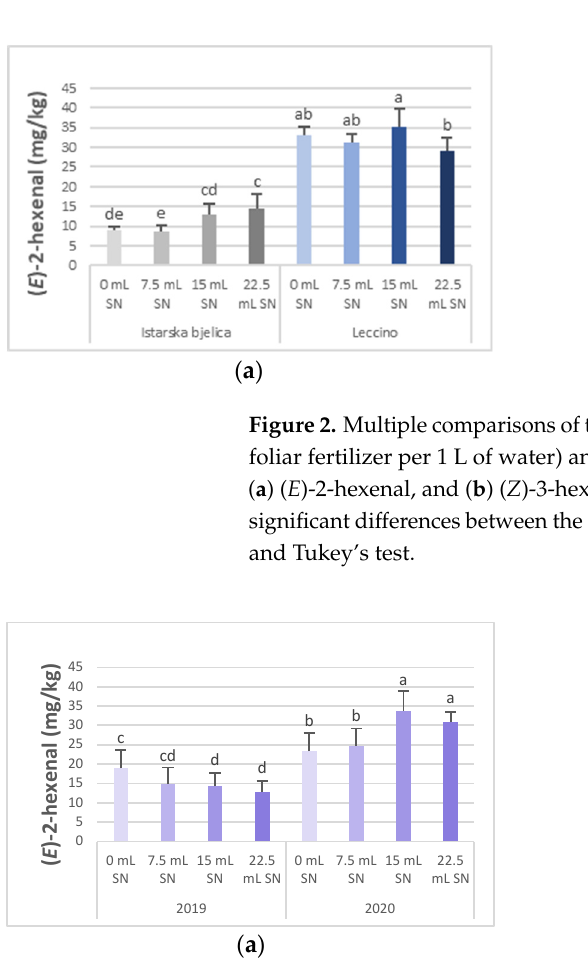
Figure 3. Multiple comparisons of the effects of treatment (T) (0, 7.5, 15, and 22.5 mL of applied SN foliar fertilizer per 1 L of water) and year (Y) (2019, 2020) on the concentration of ( a ) ( E )-2-hexenal, and ( b ) 1-penten-3-one. Different superscript lowercase letters represent statistically significant differences between the mean values at p < 0.05 that were obtained by a three-way ANOVA and Tukey’s test.